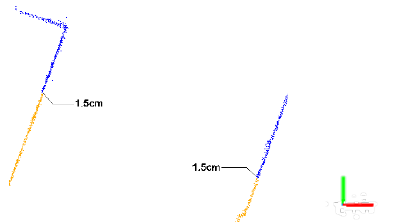
Figure 7. Distances between two segments of point clouds after segmentation (blue and orange points) in X,Y 4.2.2 Vertical Loop of dataset 1: The processing steps carried out for the vertical loop are similar to those considered for the horizontal loop. After manual registration and segmentation, an RMS of 7 cm is obtained after ICP. This deviation is too high, and the bad results are confirmed by the M3C2 distances obtained (Figure 8).